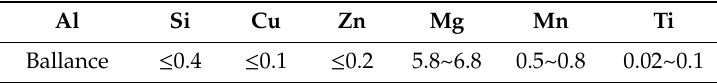
Table 1. Chemical components of ANSI 5A06 material (wt %).